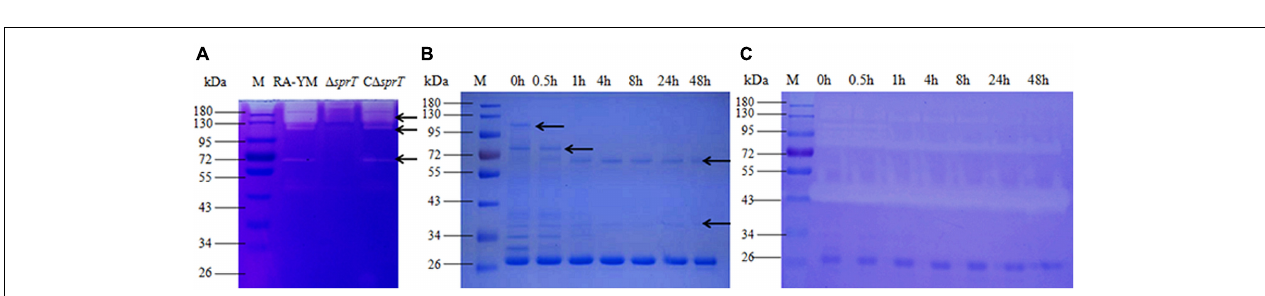
FIGURE 2 | Serum survival of wild-type strain RA-YM, mutant strain (cid:49) sprT , and complemented strain C (cid:49) sprT . (A) Effect of sprT mutation on resistance of RA to duck serum. Strains were treated with 6.25% normal duck serum for 30 min at 37 ◦ C and plated for survival analysis. (B) Effect of sprT mutation on resistance of RA to alternative complement pathway-mediated killing. Cells were treated with 12.5% normal duck serum in the presence of Mg 2 + EGTA for 30 min at 37 ◦ C and plated for survival analysis. Data were analyzed with Student’s t- test ( ∗ P < 0.05, ∗∗ P < 0.01).